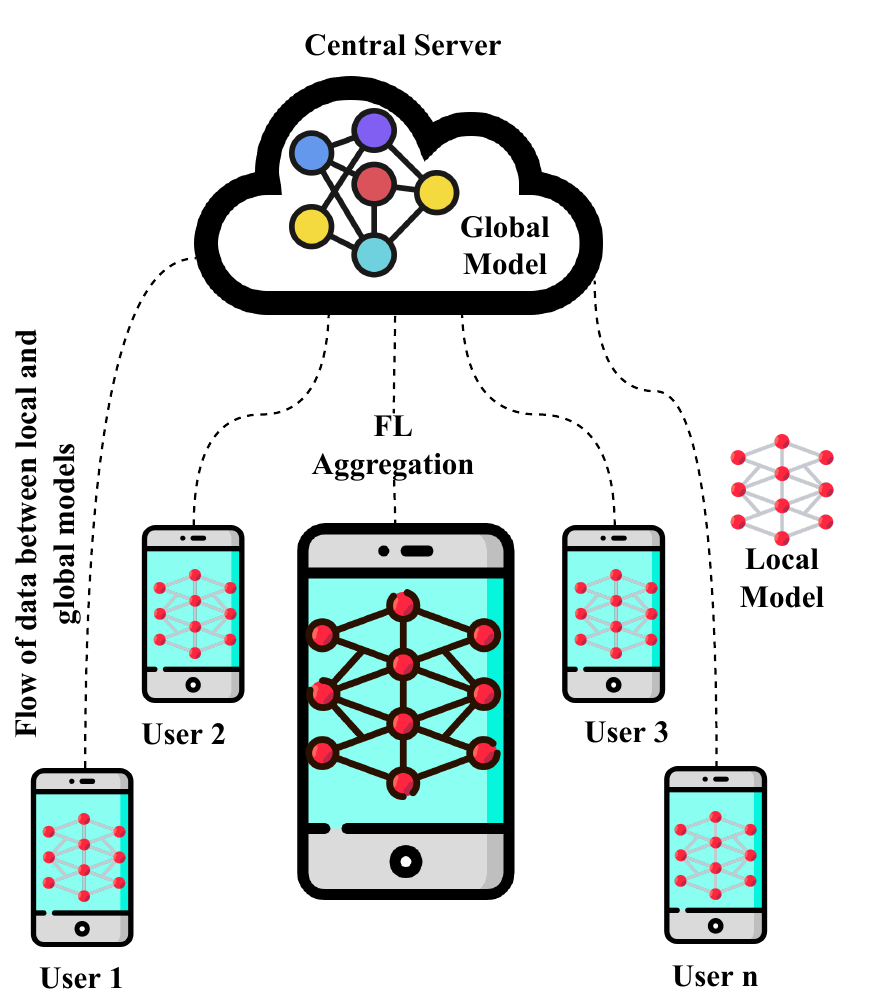
Figure 1. Federated Learning